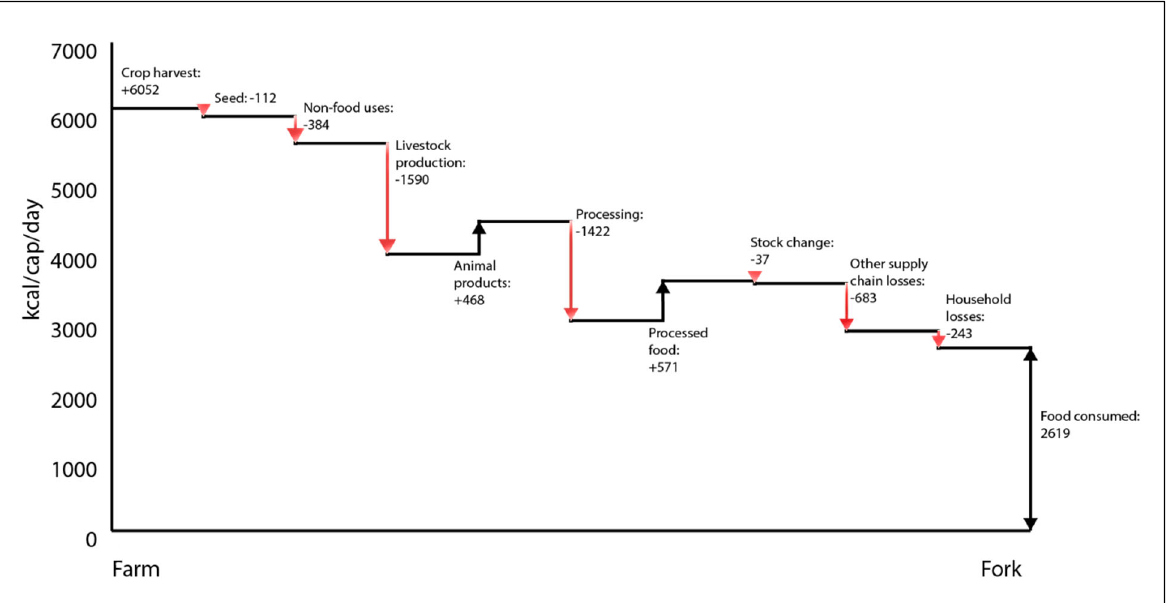
Figure 1. Schematic of Global Post-harvest Food Loss and Waste (FLW) (kcal per capita per day a )